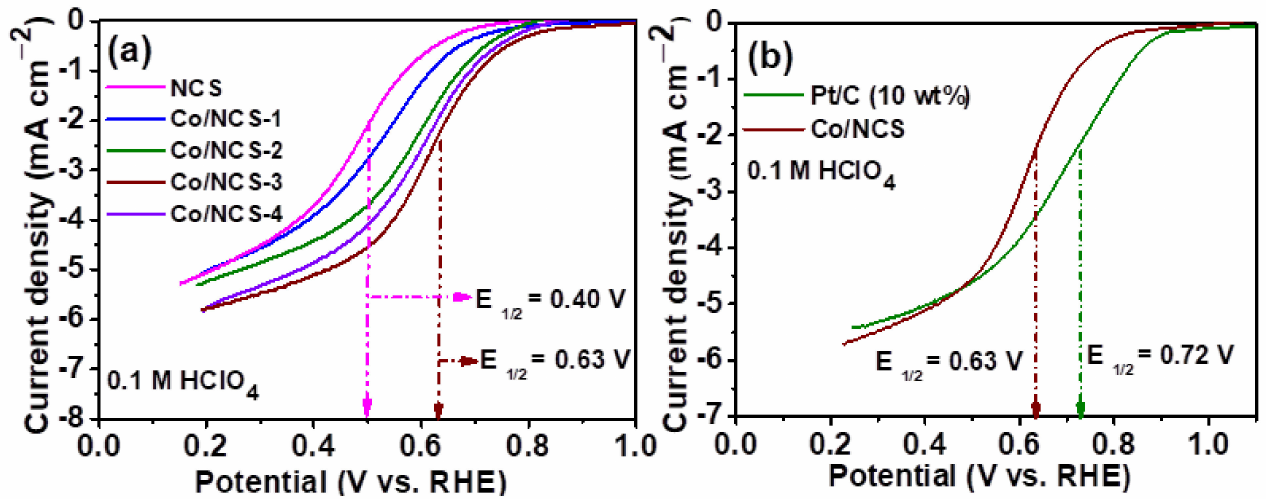
Figure 6. ( a ) Linear Sweep Voltametric (LSV) curves of Co/NSC catalysts with different Co contents ( b ) Comparison of LSV curves of Co@NSC-3 catalyst with commercial Pt/C (10 wt.%). Electrolyte: 0.1 M HClO 4 , scan rate: 10